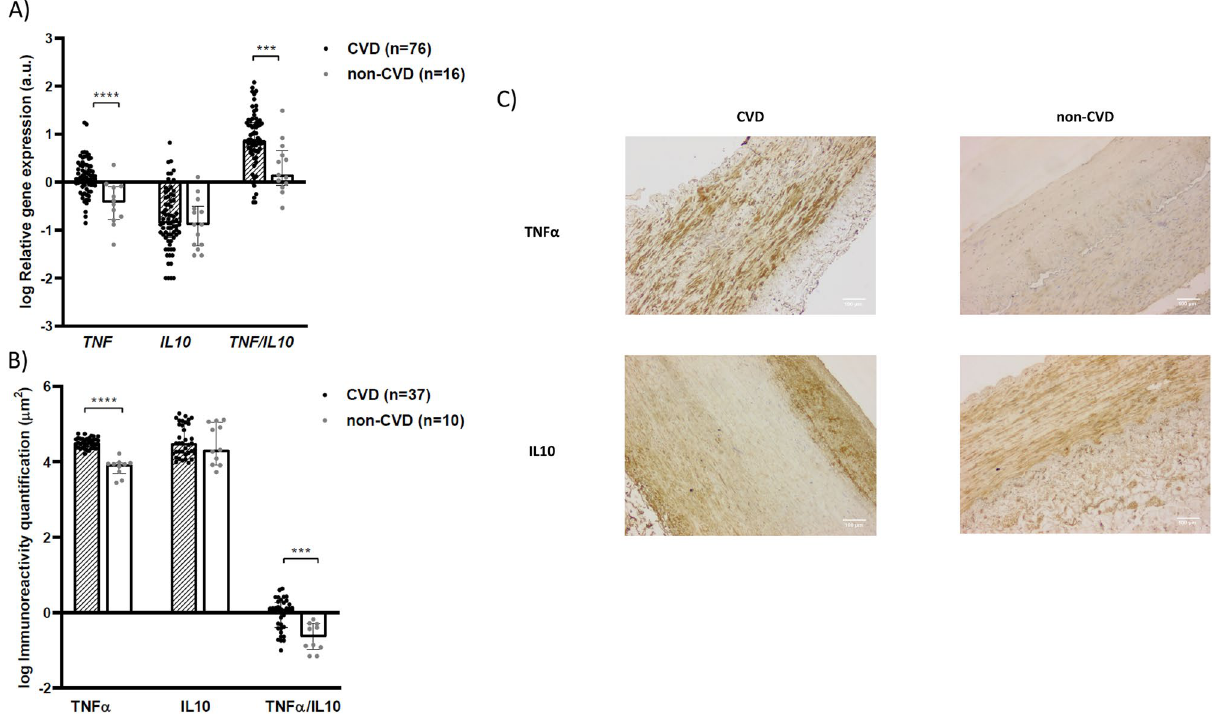
Figure 2. Inflammatory markers in the vascular wall of CVD and non-CVD subjects. ( A ) Relative gene expression levels and ( B ) immunoreactivity levels for TNF, IL10 and their ratio. ( C ) Immunohistochemistry images for TNFα and IL10. a.u.: arbitrary units. Bars and range represent median and IQR. ***: P < 0.001; ****: P <